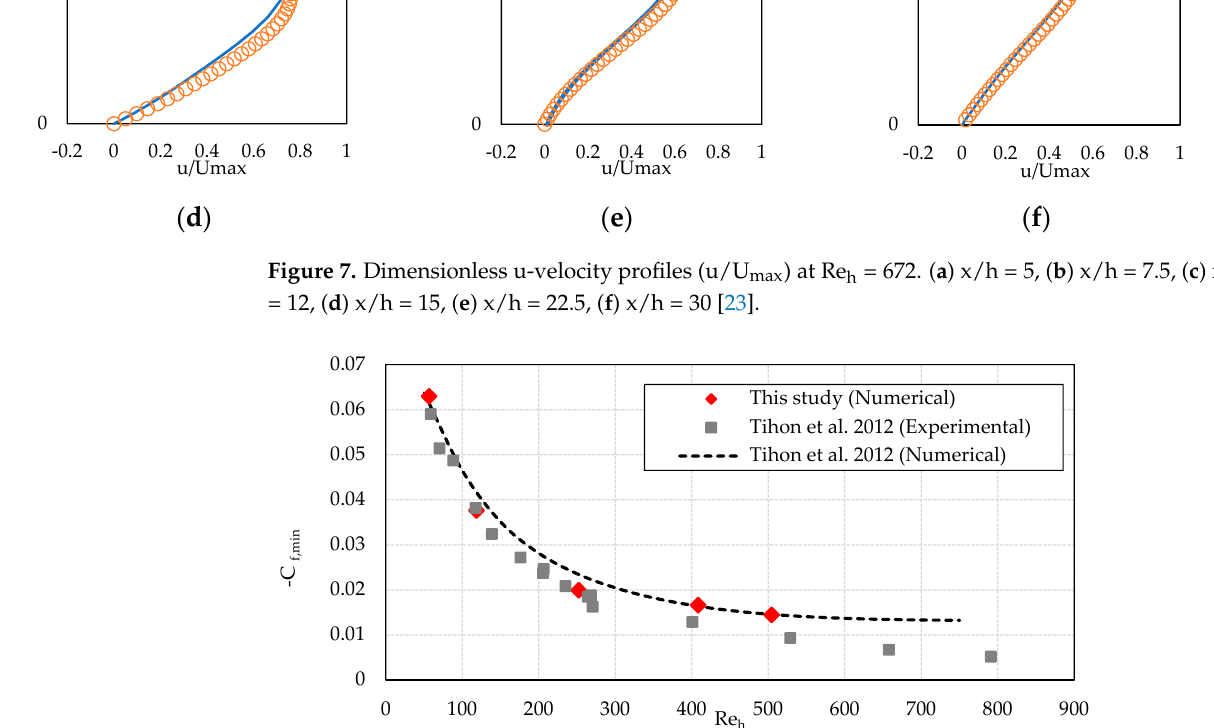
Figure 8. Dimensionless C f, min vs. Re h in laminar flow [19]. The minimum peak of the skin friction coefficient (C f, min ) was observed inside the primary recirculation zone. The average error between the numerical results of this study and the literature experimental and numerical results [19] was lower than 20% and 8.5%,